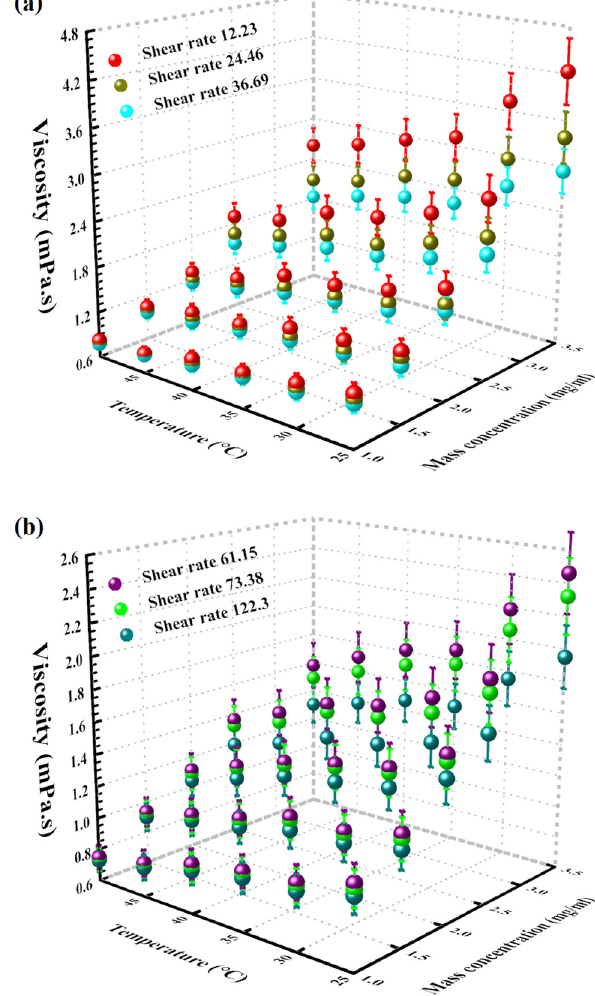
Figure 13: The 3D factual outcome of viscosity at dissimilar tem - peratures and mass concentrations.